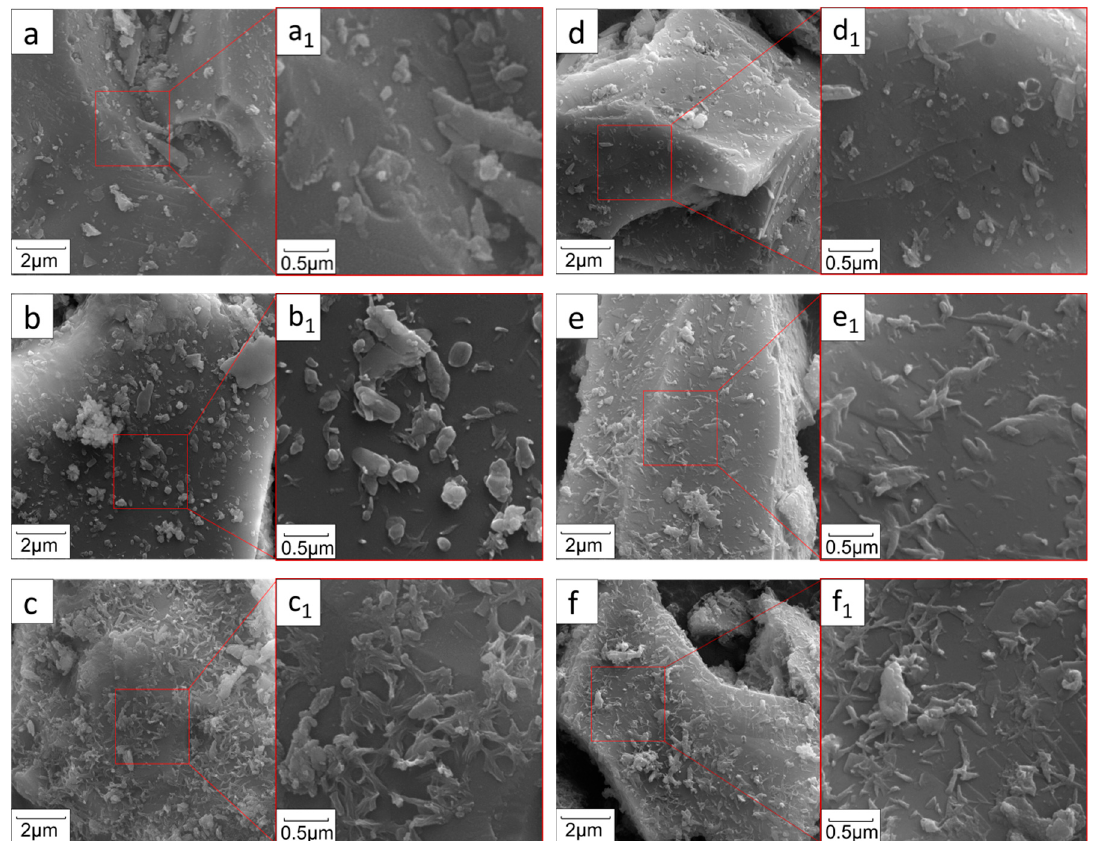
Figure 9. Morphology of hydration products on surface of PP particle at 1 h ( a and a 1 ), 4 h ( b and b 1 ), 7 h ( c and c 1 ) and quartz particle at 1 h ( d and d 1 ), 4 h ( e and e 1 ), 7 h ( f and f 1 ) ( a , b , c , d , e , and f are 25000×, and a 1 , b 1 , c 1 , d 1 , e 1 , and f 1 is 90000×).